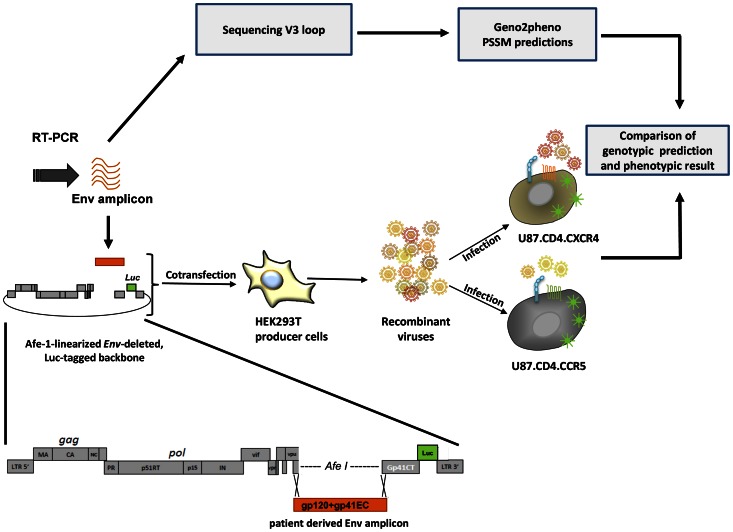
Study design/RVA design.Viral RNA was extracted from patient plasma RT-PCR amplified. Env amplicons spanning the Env ectodomain were further amplified through an inner PCR. Five independent PCRs were pooled to minimize PCR-selection. Recombinant viruses were produced by co-transfecting HEK293T cells with Afe I-linearized, luciferase-tagged, Env-deleted, viral backbone and patient-derived PCR amplicon. Normalized amounts of recombinant viruses were used to infect U87.CD4.CCR5 or U87.CD4.CXCR4 indicator cells. Infection was monitored by quantifying luminescence in the cell lysates. Depending on the outcome of the infection, viruses were classified as either CCR5 tropic, CXCR4 tropic or dual/mixed. The same patient-derived PCR amplicon used for viral production was sequenced and tropism inferred by Geno2Pheno[coreceptor] and webPSSM algorithms. The phenotypic and genotypic results were compared. Abbreviations: Env EC: Env ectodomain; gp41-TM-CT: gp41 Transmembrane+cytoplasmic tail.